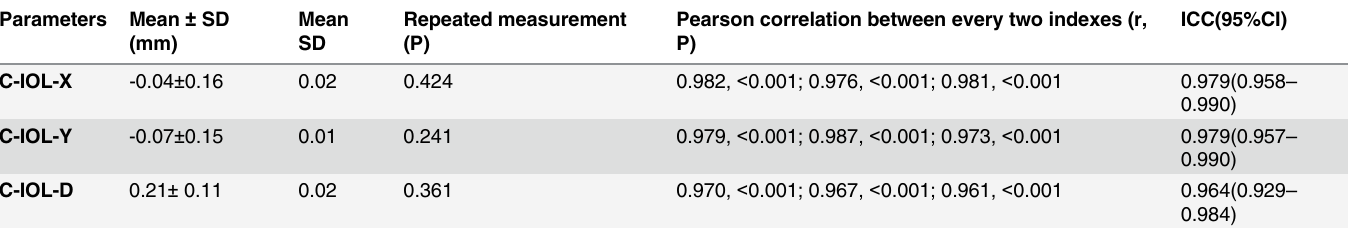
Table 7. The repeatability results of C-X, C-Y, C-D using different statistical analysis methods. Parameters Mean ± SD Mean Repeated measurement (mm) SD (P)